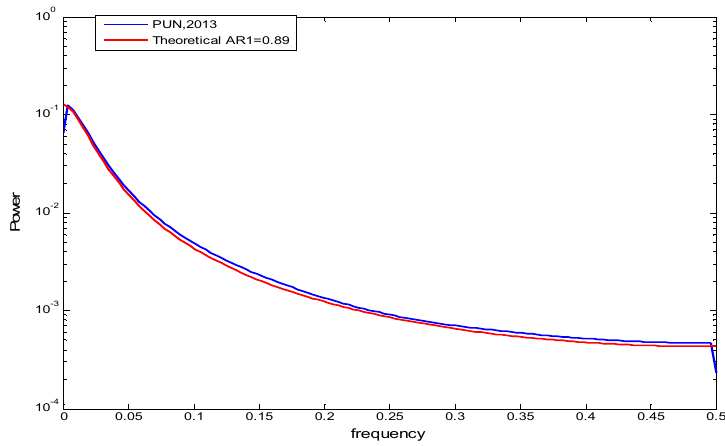
Figure 9. The theoretical Fourier Power spectrum of an AR (1) process, with lag-1 autocorrelation a = 0.86 (estimated by fitting an AR (1) model on the observed PUN hourly time series for 2013, as given by relation Equation (11)) and the Power spectrum of the PUN time series 2013 estimated by a typical Burg’s algorithm. The two curves, decay with almost the same behaviour.